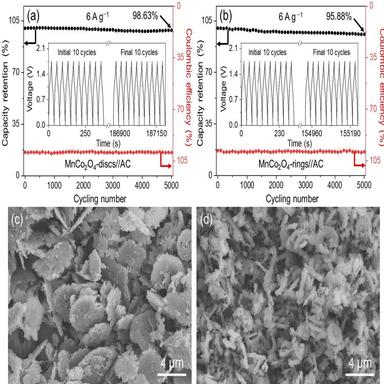
Cycling performance and Coulombic efficiency of (a) MnCo2O4-discs//AC ASC and (b) MnCo2O4-rings//AC ASC after 5000 cycles at 6 A/g; the SEM images of (c) MnCo2O4-discs and (d) MnCo2O4-rings after cycling; the insets of (a, b) show the initial 10 GCD curves and the final 10 GCD curves during cycles.